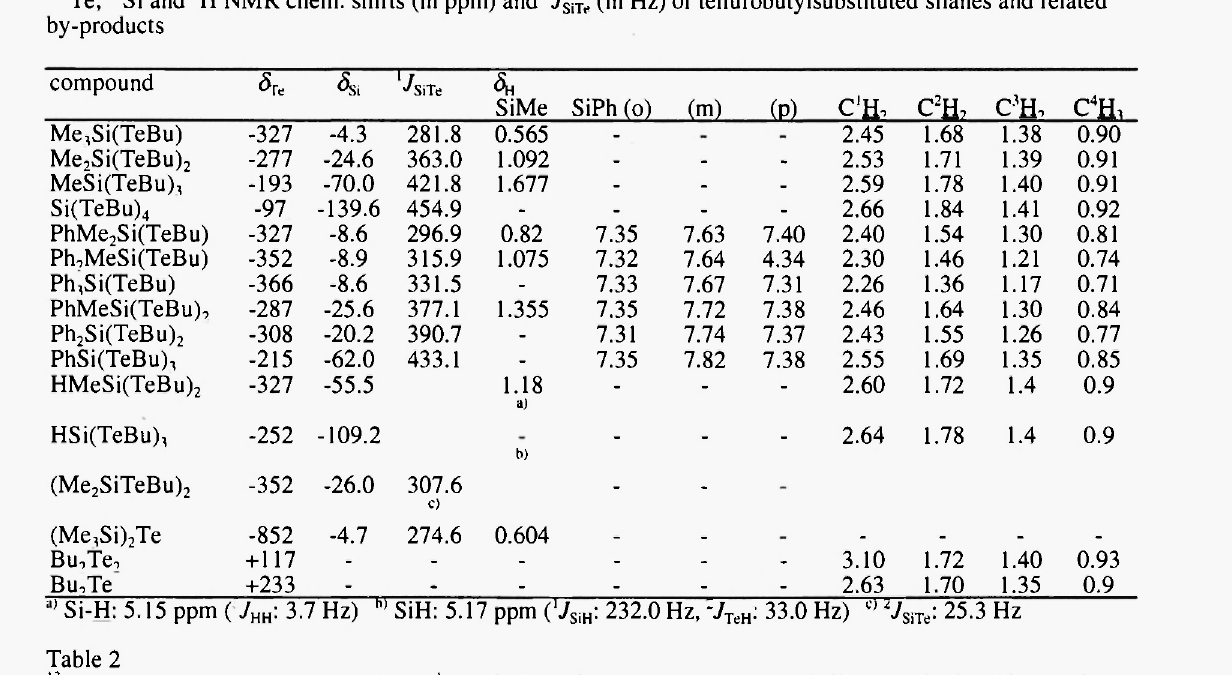
Table 1 l25 Te, 29 Si and 'H NMR ehem. shifts (in ppm) and 'y by-products compound